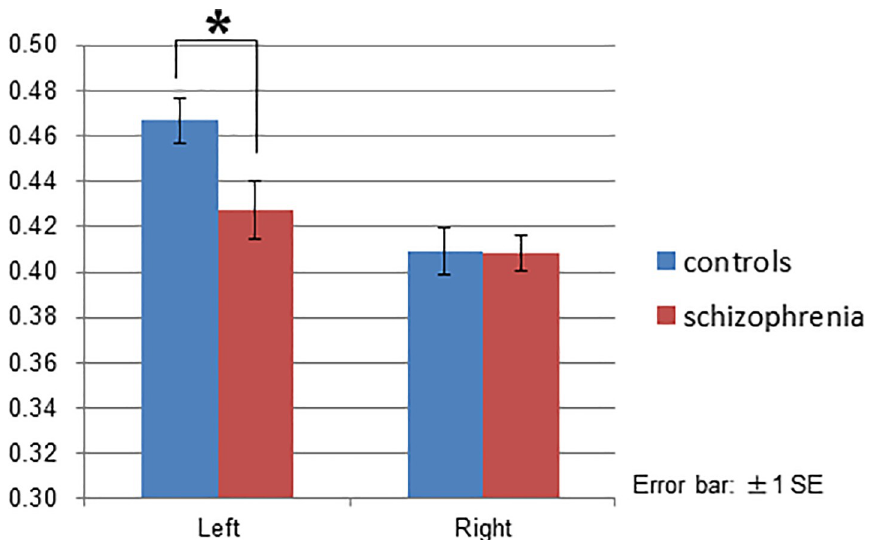
Fig 13. Fractional anisotropy (FA) values in the anterior cingulate gyrus. Patients had reduced FA values in the left anterior cingulate gyrus.